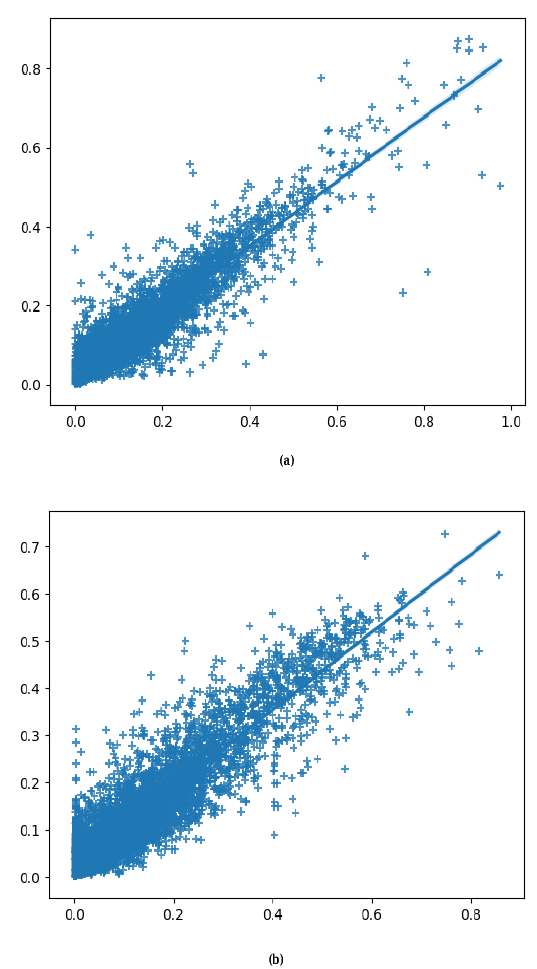
Figure 1. Regression lines of RF for Guanyuan City Weather Station Data (a) for PM 2.5 and (b) for O